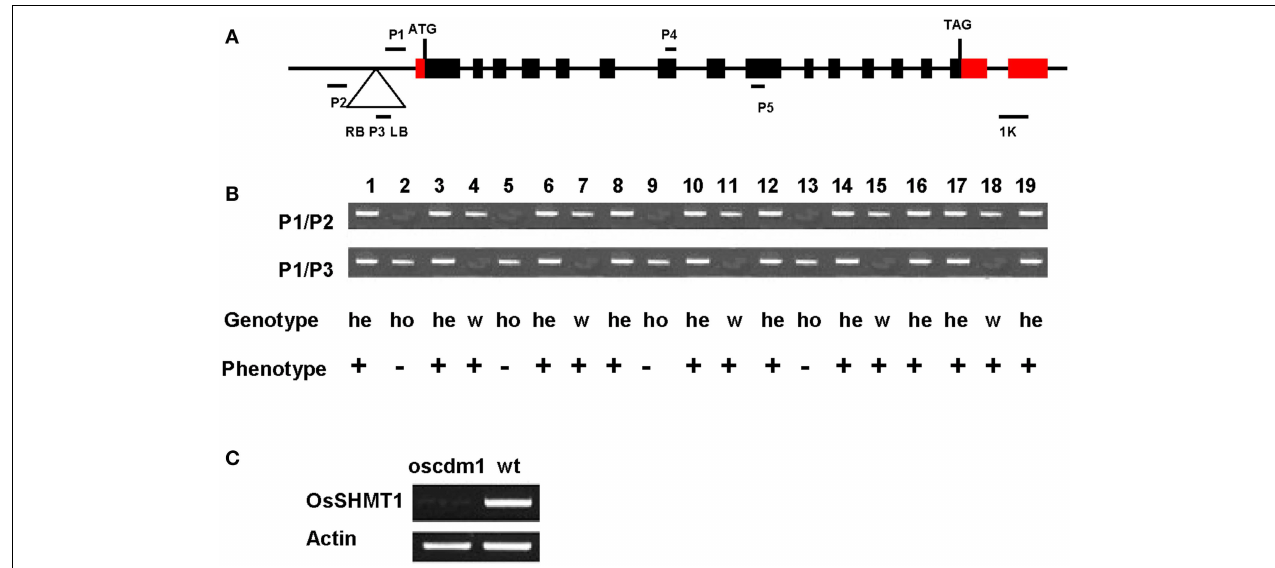
FIGURE 4 | Co-segregation of the T-DNA with the chlorina phenotype. (A) Schematic representation of the T-DNA insertion upstream of OsSHMT1 (exons = black/red boxes; introns = black lines) and the domain organization of OsSHMT1 (http://www.uniprot. org/uniprot/Q6EPF0). ATG, start codon; TAG, termination codon; RB, right border; LB, left border. P1, P2, and P3 are the primers used for genotyping. (B ) Co-segregation analysis of the genotype and phenotype in a segregating population. All plants homozygous for the T-DNA insertion showed a chlorotic phenotype, indicating that the recessive mutation was caused by T-DNA insertion. Numbers represent the different plants tested. P1/P2, PCR using primers P1 and P2; P1/P3, PCR using primers P1 and P3; He, hemizygous; Ho,